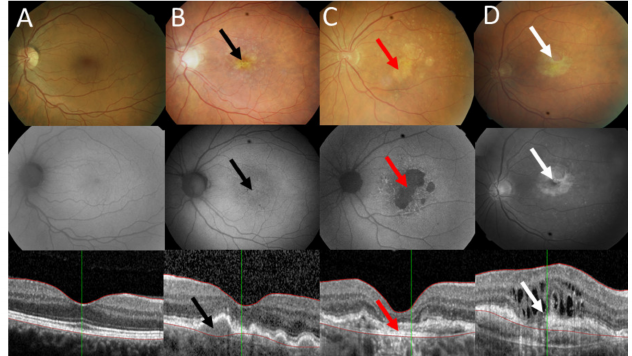
Figure 1. Clinical presentation of age-related macular degeneration. Fundus photograph (upper panel), autofluorescence (middle panel), and optical coherence of normal eye ( A ), intermediate dry AMD with drusen (black arrows) ( B ); advanced geographic atrophy with typical GA lesions (red arrows) ( C ); and wet AMD with subretinal and with fibrotic signs (white arrows) ( D ). Positive family history is, apart from aging, the strongest AMD risk factor.